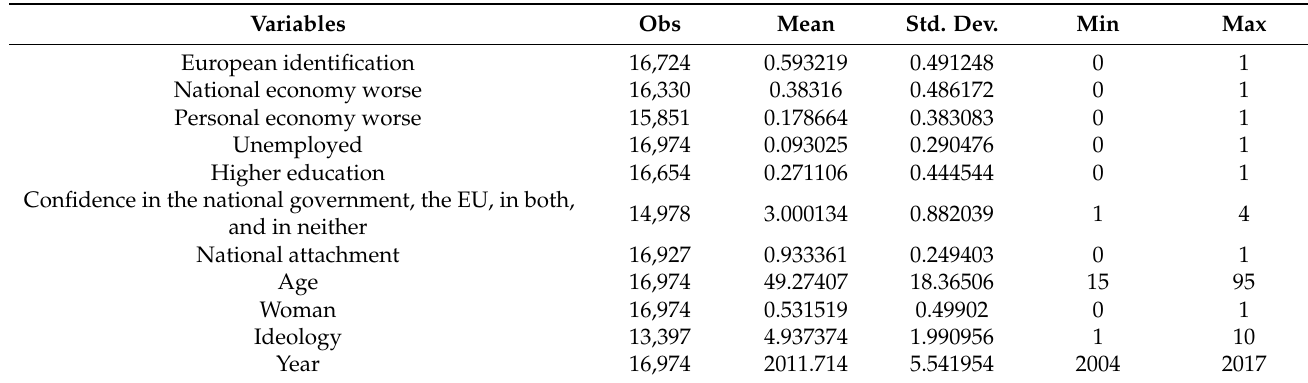
Table A2. Descriptive statistics of all